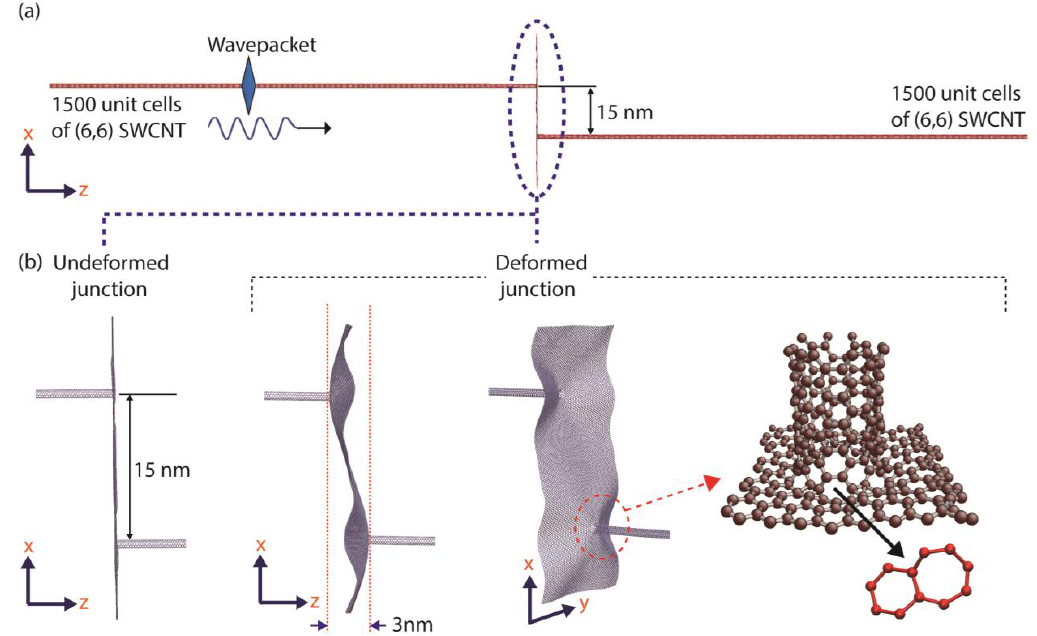
Figure 1. ( a ) The schematic of phonon wavepacket analysis. Interplanar spacing between (6,6) SWCNT – graphene junctions is fixed to be 15 nm. ( b ) Junction structures with undeformed and de- formed junctions and a 5 – 7 defect in the junction are illustrated. The junction structure is deformed uniaxially into z direction until the distance between the two SWCNT – graphene junctions reaches 3 nm. reaches 3 nm.